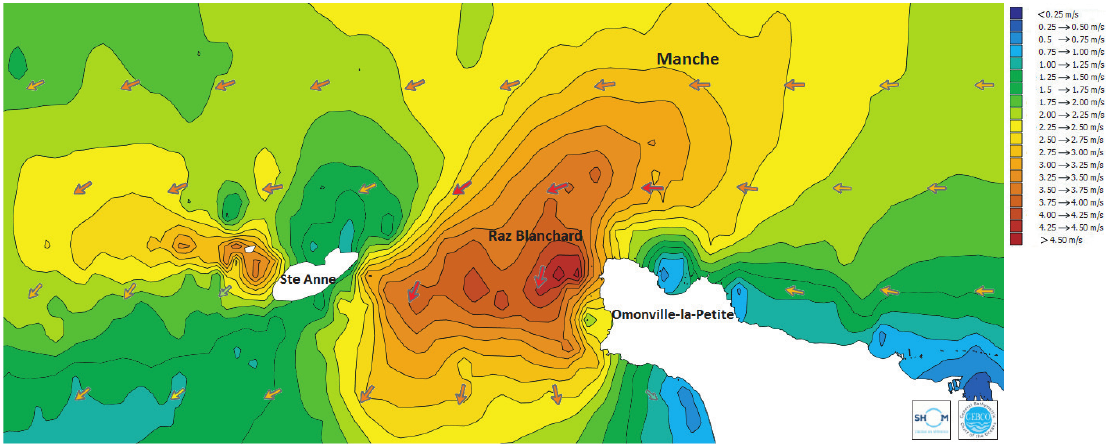
Figure 1. Tidal current speed in Alderney Race in the French western